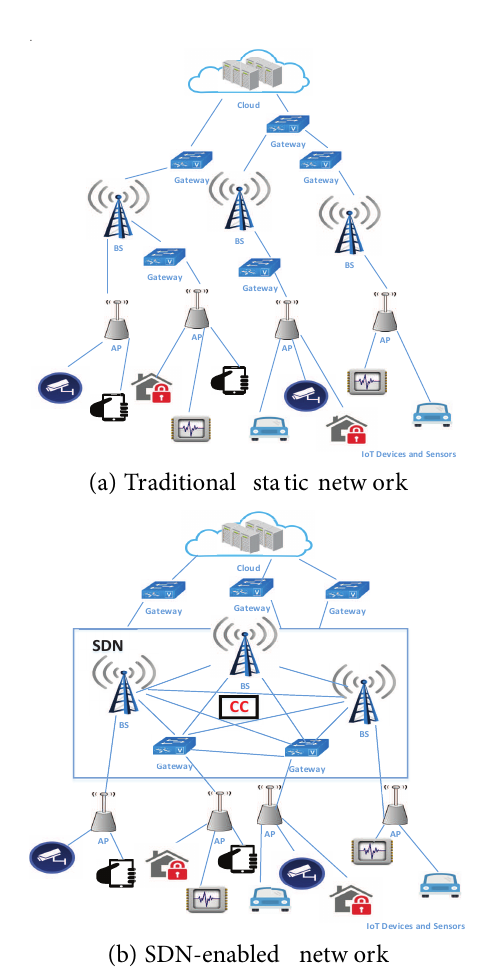
Figure 1. Networking architecture for